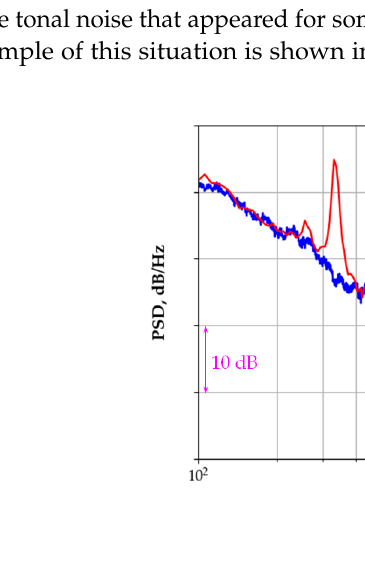
Figure 17. Localization of noise sources for the six-wheel landing gear model with high main leg. Flow speed is 75 m s − 1 ; frequency is 1250 Hz.